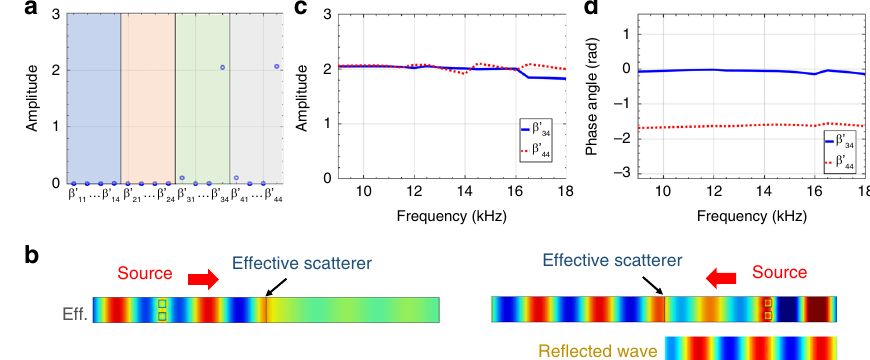
Fig. 4 Effective polarizabilities of the Willis meta-layer. a Numerically retrieved amplitudes of the 16 normalized polarizabilities using the wave fi elds calculated in Fig. 3e at 10 kHz. Source data are provided as a Source Data fi le. b Numerically simulated wave fi elds at 10 kHz using the effective model characterized by the polarizabilities in Fig. 4a. ( c , d ) Numerically retrieved ( c ) amplitudes and ( d ) phase angles of normalized nonzero polarizabilities using the wave fi elds calculated in Fig. 3e. Source data are provided as a Source Data fi